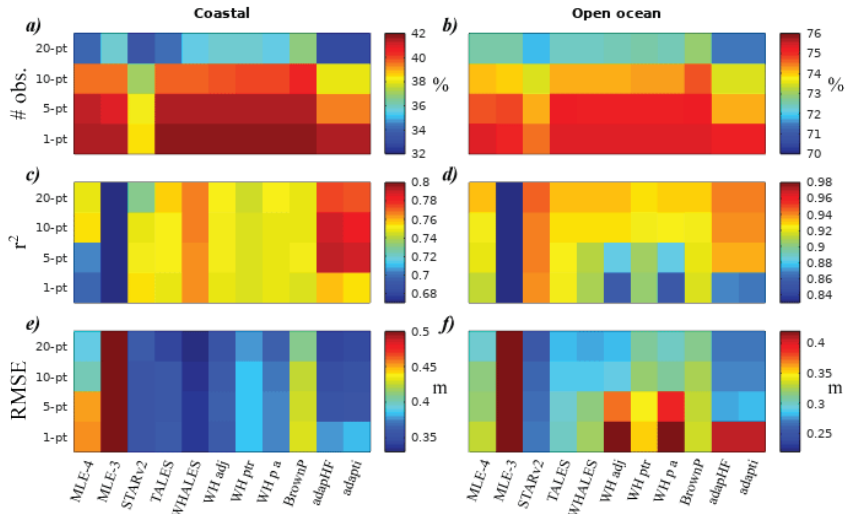
Figure 5. Effect of raising the minimum no. of observations on the number and quality of the median estimate by the Jason-3 altimeter. ( a , b ) show the percentage of passes exceeding the eligibility threshold; ( c , d ) show the r 2 values and ( e , f ) the RMSE upon comparison with buoys. Note that the bottom row is for a minimum of one point contributing to the median, and thus includes all the cases where 20 points are present plus those when between 1 and 19 are valid. Different colour scales are used for coastal (buoy within 15 km of coastline) and open ocean conditions to allow the variations in each panel to be clearly